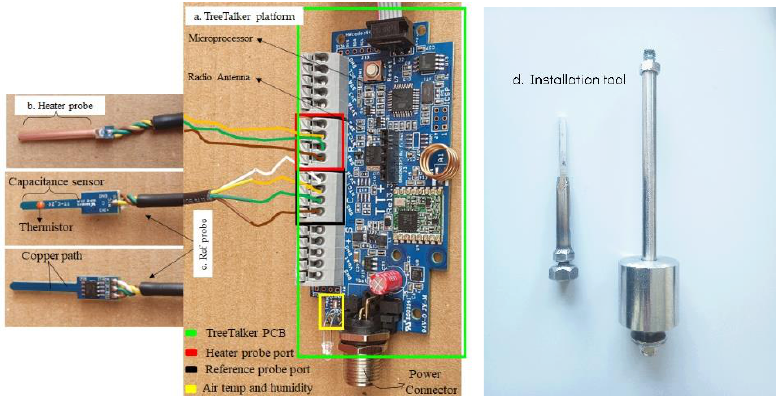
Figure 1. ( a ) TT+ layout, ( b ) Heater probe including a thermistor (NTC) and a heater resistance, which are placed in a conductive paste, ( c ) Ref probe including a thermistor (NTC) and a copper path as a capacitance oscillator, and ( d ) installation of two TreeTalkers (TT+) on a beech tree.